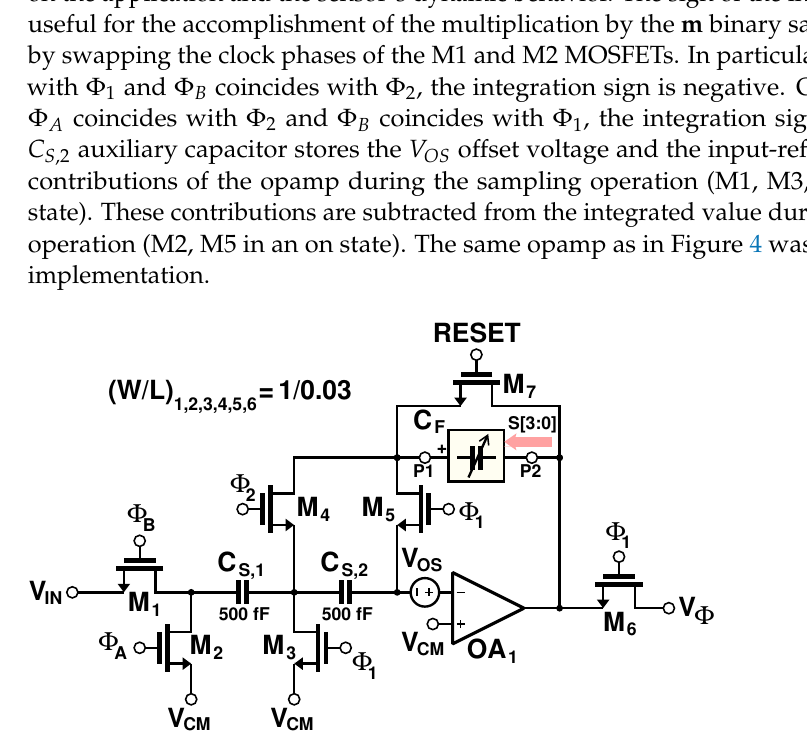
Figure 5. Circuit schematic of the implemented switched-capacitor integrator. The specified width/length are reported in µm for each MOSFET.